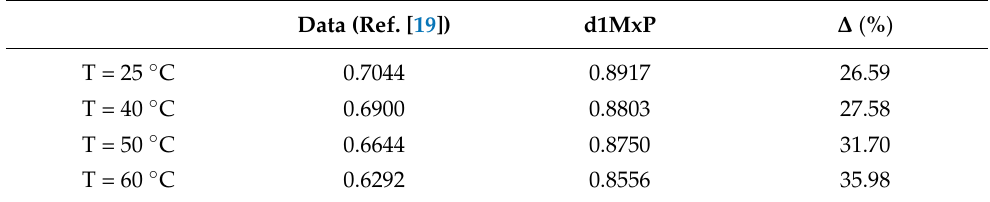
Table 6. Fill Factor values obtained using different